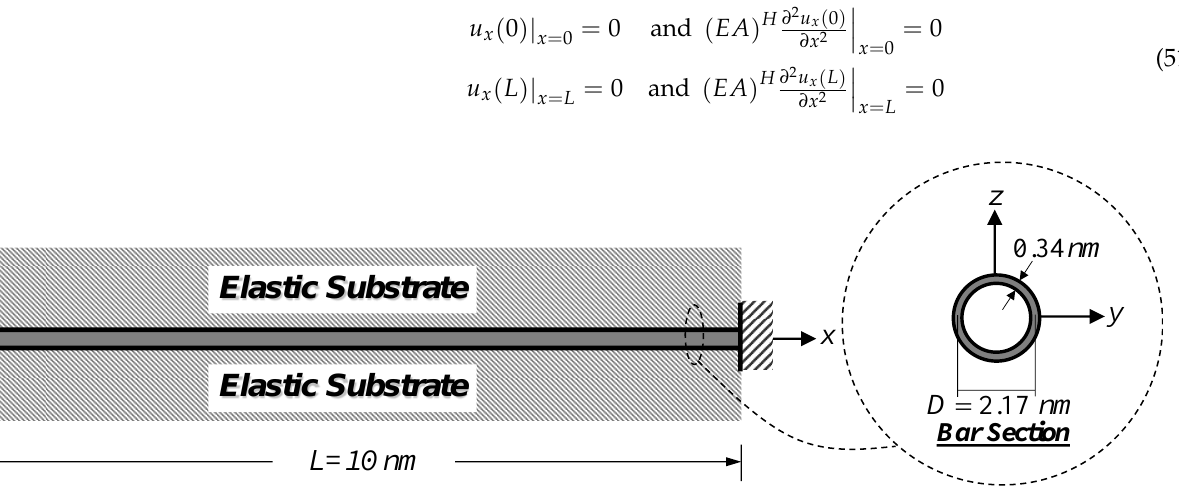
Figure 8. Clamped – clamped SWCNT embedded in the substrate medium: free vibration analysis. Figure 8. Clamped–clamped SWCNT embedded in the substrate medium: free vibration